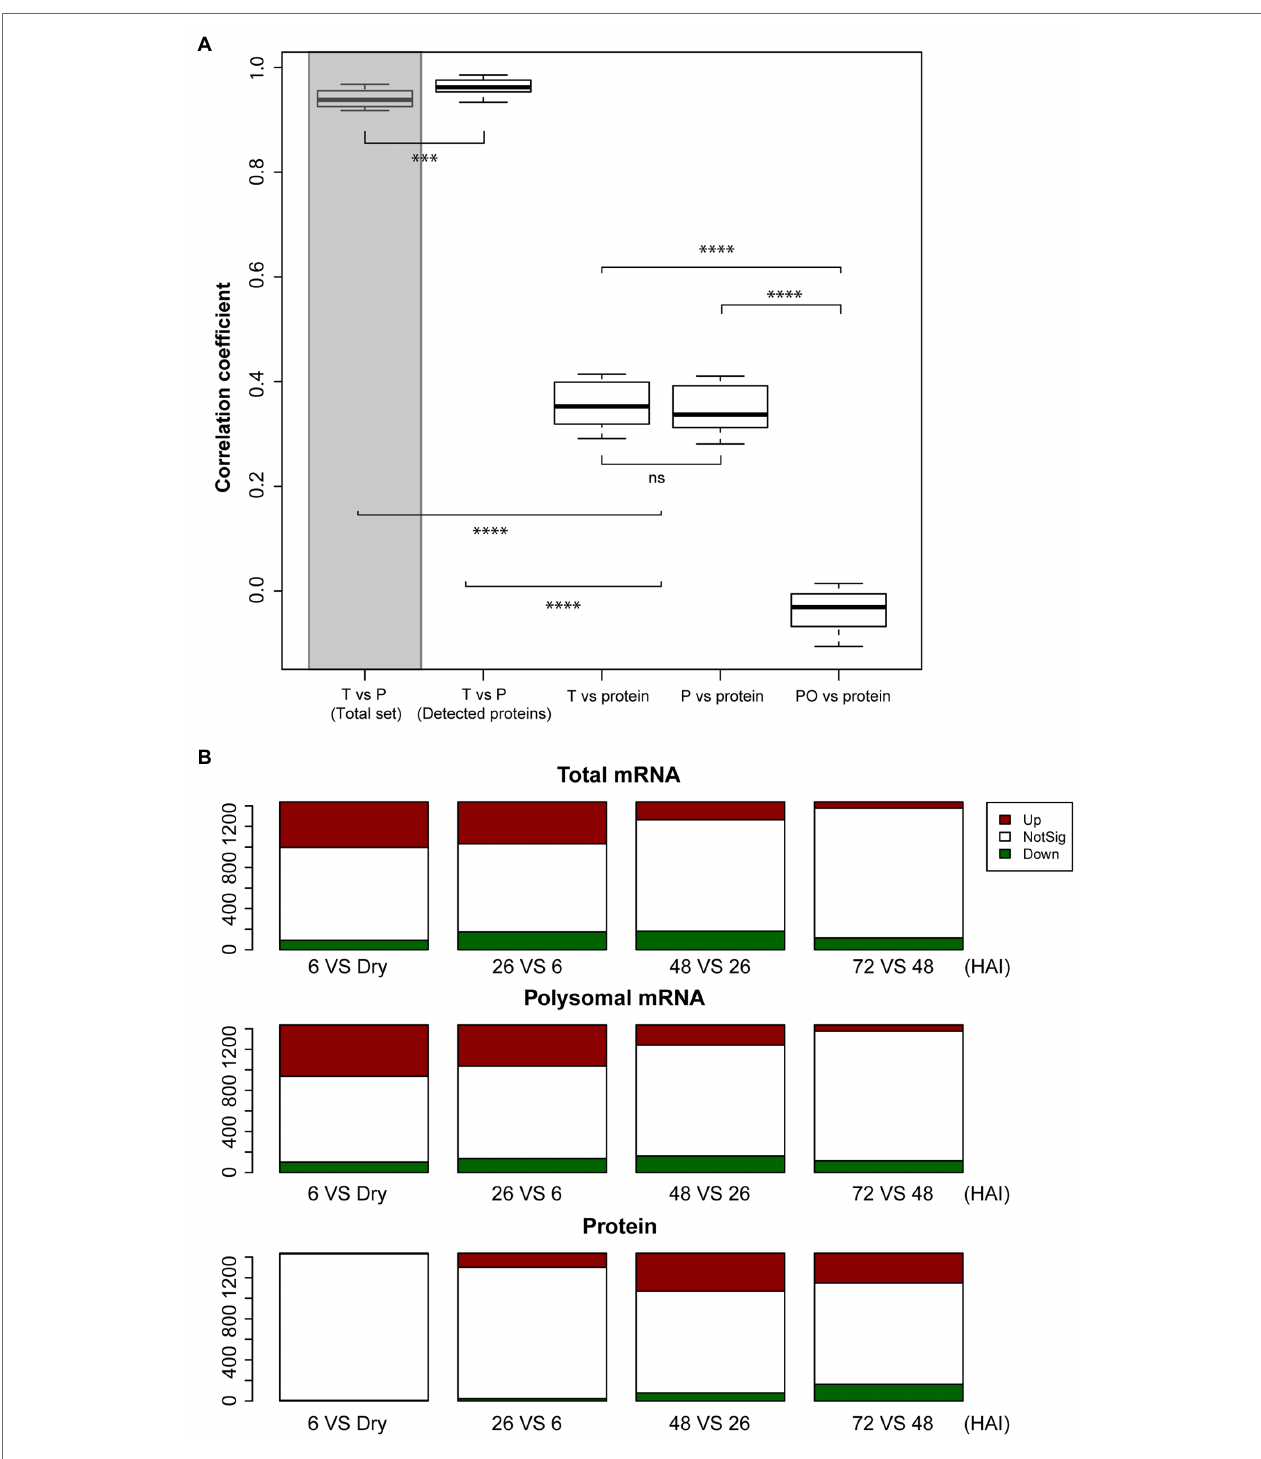
FIGURE 2 | Lack of correlation between total mRNA, polysomal mRNA, and protein abundance during seed germination. (A) Distribution of Spearman correlation coefficients (five time-points and three biological replicates) between total mRNA (T) and polysomal mRNA (P) for the total set of identified mRNAs (Total set; shaded bar) and the mRNAs with identified protein (Detected proteins), total mRNA and protein, polysomal mRNA, and protein as well as the polysomal occupancy (PO) and protein (ns; p > 0.05; ** p < 0.01; *** p < 0.001; **** p < 0.0001; Wilcoxon rank-sum test). (B) Differential expressed genes in total mRNA, polysomal mRNA, and protein during seed germination following hours after imbibition (HAI). The genes upregulated (Up, red) and downregulated (Down, green) are displayed in comparison with the non-significant (NotSig, white) changed